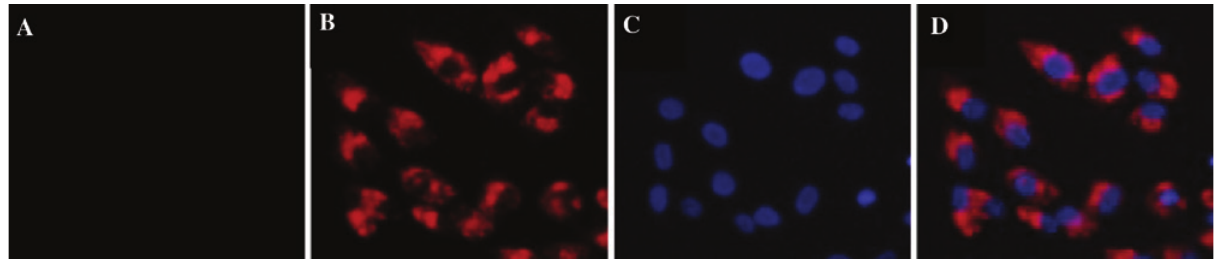
Figure 10: Fluorescence images of MG-63 cells. Reprinted from Wang et al.